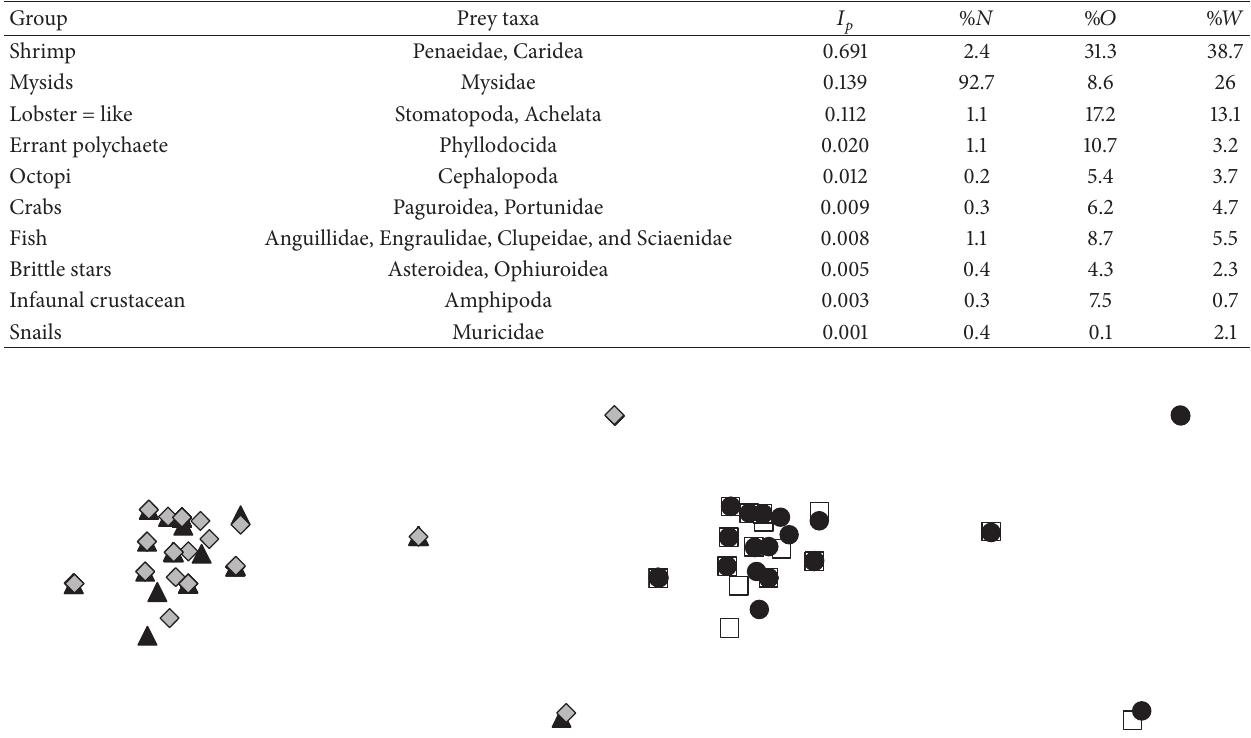
Table 2: Indices describing the importance of functional prey groups of Pomadasys panamensis as described by the index of preponderance ( 𝐼 𝑝 ), percentage abundance (% 𝑁 ), frequency of occurrence (% 𝑂 ), and percentage weight (% 𝑊 ).